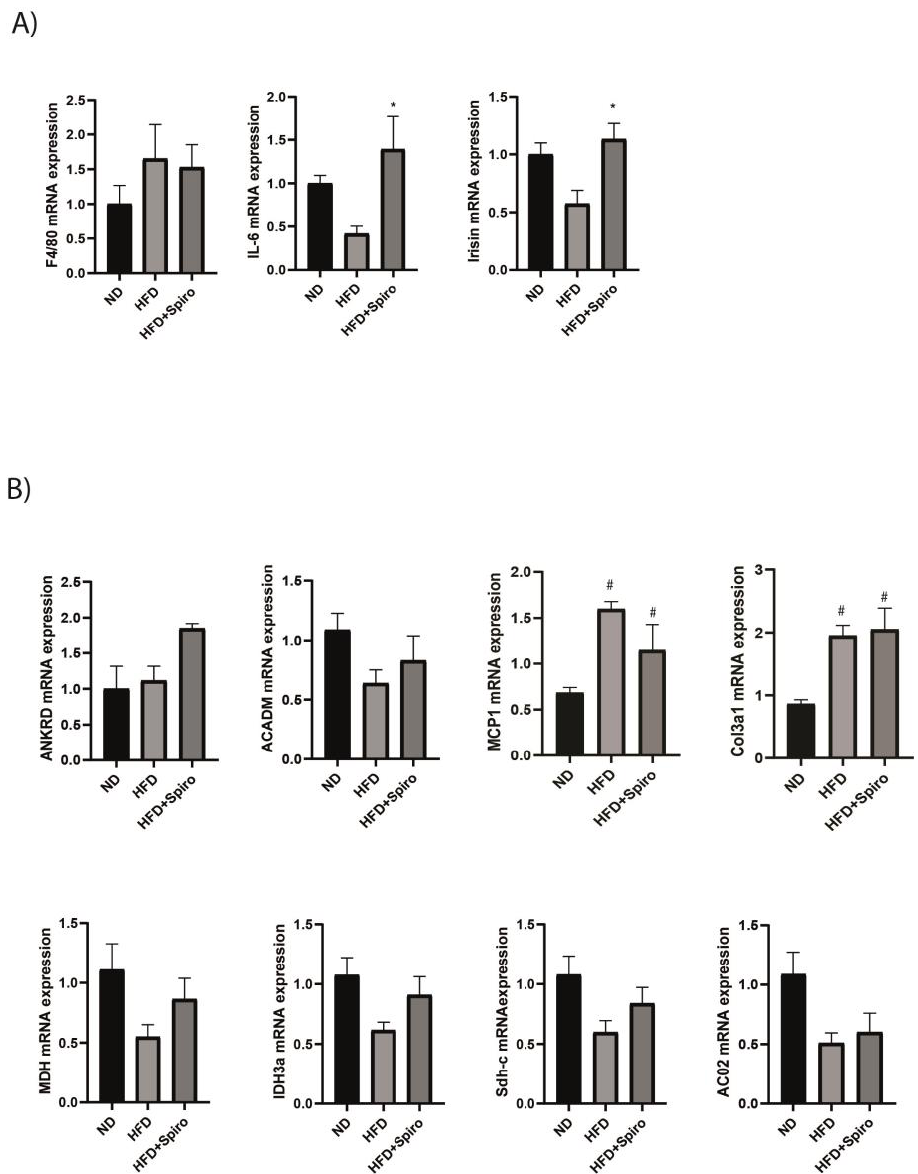
Figure 5. Specific MR blockade by spironolactone regulates the myokines profile of mice fed an HFD. ( A ), qRT-PCR analysis of genes related to F4/80, IL-6, and Irisin; ( B ), ANKRD, mitochondrial fatty acid uptake, inflammation, fibrosis, fatty acid oxidation (FAO), and the tricarboxylic acid cycle (TCA) in GA of ND, HFD, and HFD + Spiro groups (n = 10). * p < 0.05 vs. HFD; # p < 0.05 vs. ND. Values are expressed as means ± SEM .